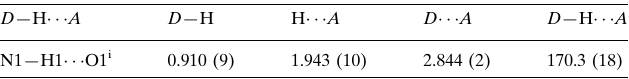
Hydrogen-bond geometry (A˚ , (cid:1)